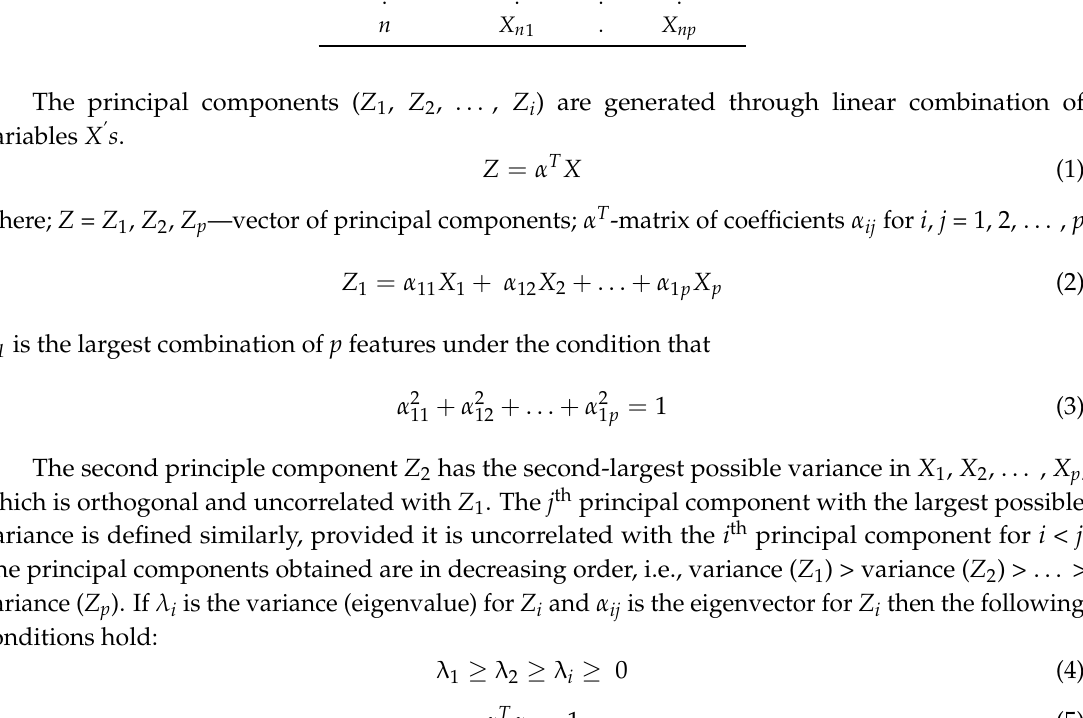
Table 1. Form of data for Principal component analysis with n cases each with p features. Case X 1 . X p 1 X 11 . X 1 p 2 X 21 . X 2 p . . . . . . . . n X n 1 . X